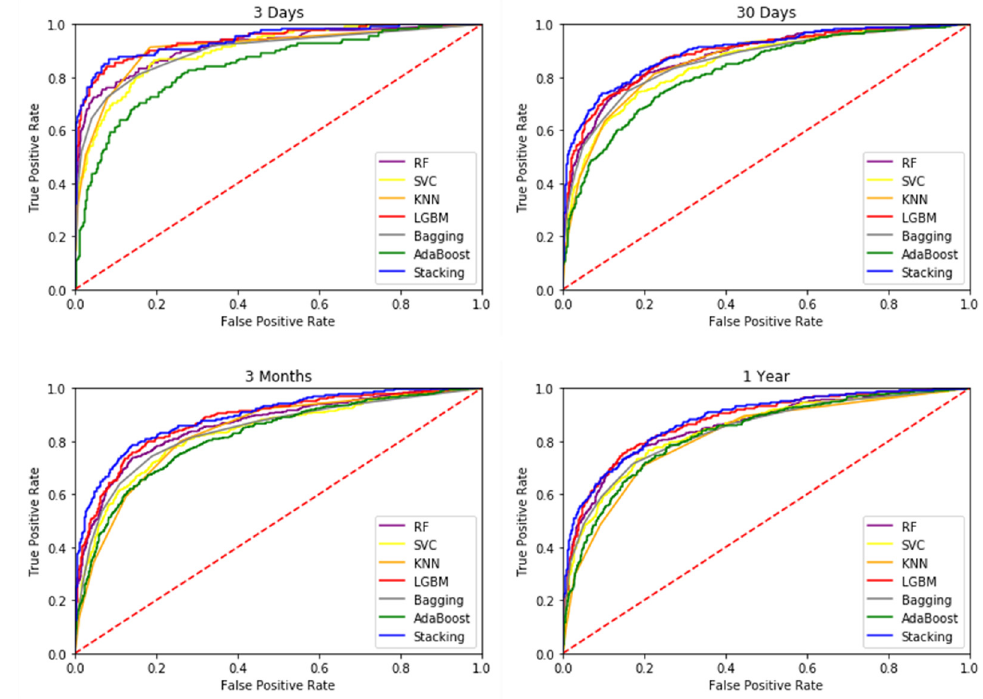
Figure 4. The ROC curves of all base models.